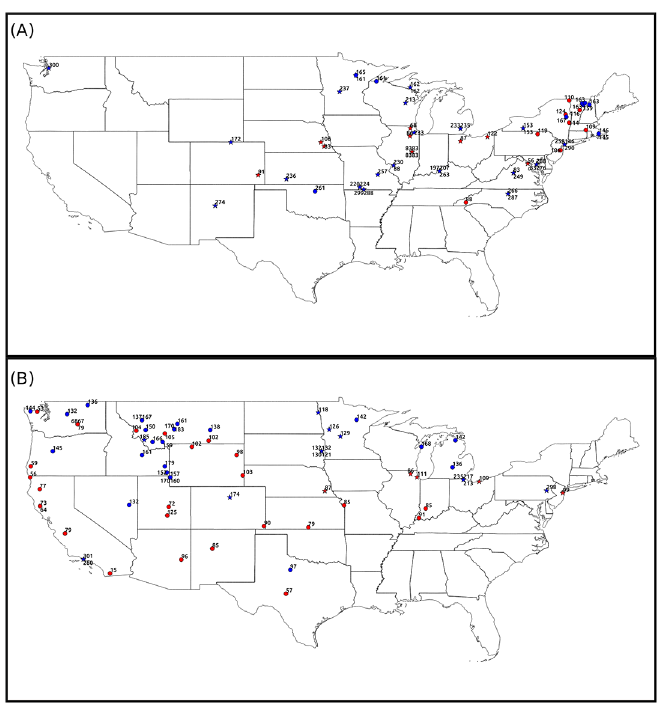
Fig 7. Plot of inconsistent phenological observations through study area. Inconsistent volunteered observations on flowering onset DOY of (A) cloned lilac and (B) common lilac. Red points show unusually early while blue ones show unusually late phenological observation. Circles show that phenological observations from historical initiatives whereas stars show phenological observations from contemporary initiatives. Inconsistencies were labeled with the day of year that lilac started